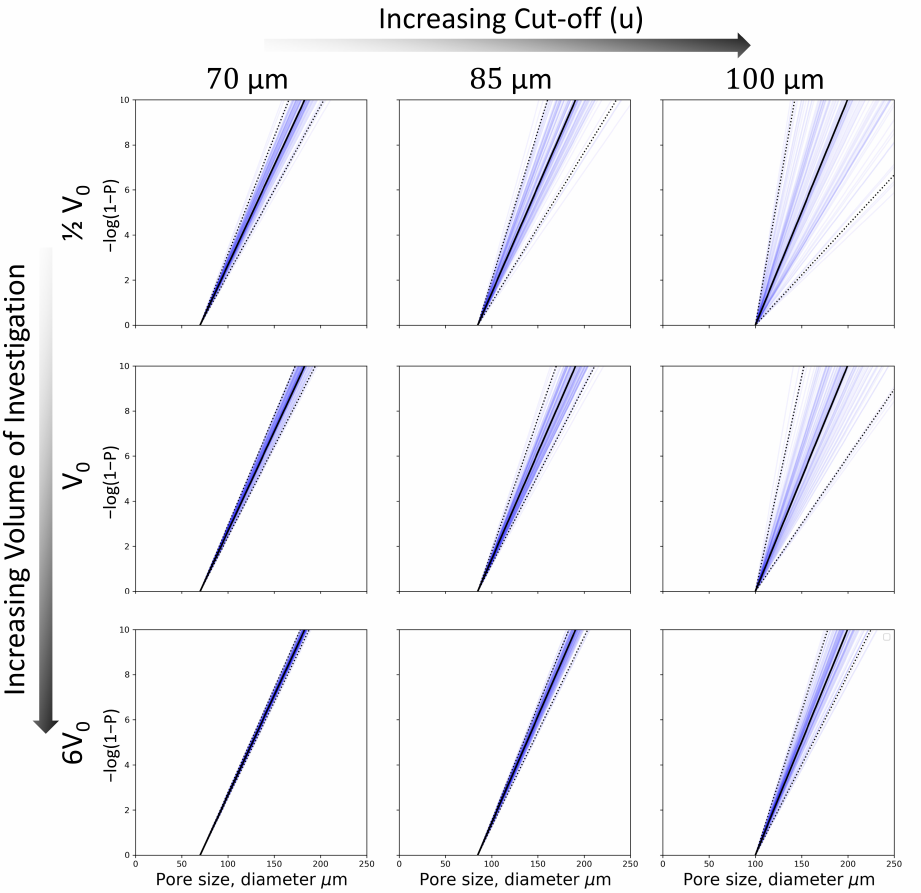
Figure 11. Scatter of the extreme value estimation of σ with increasing cut-off ( u ) and simulated volume. V 0 is the volume of one test specimen. The scatter is illustrated by maximum likelihood fitted lines to exponential probability plots of the simulated specimens. Each sub-plot contains 100 lines with the mean slope in solid black and the fifth and 95th slopes in dotted black. The bottom left plot represents the scatter of the estimation of σ in the current